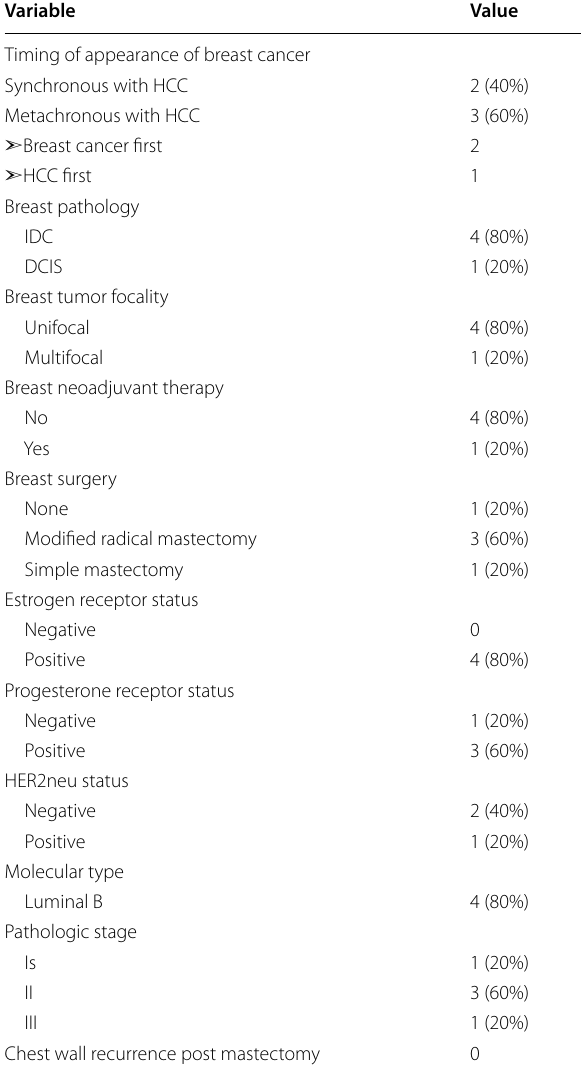
Table 3 Data about the breast cancer, its treatment, and